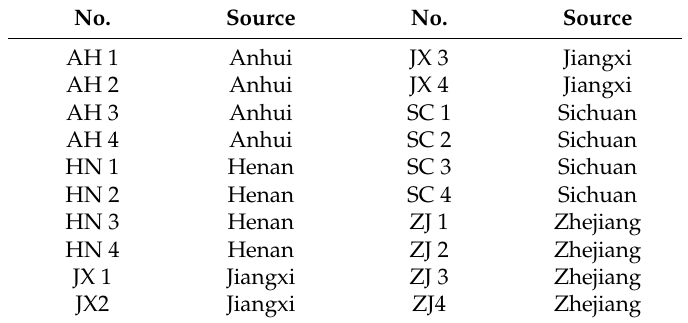
Table 3. Sources information of 20 batches of Chansu samples from di ff erent geographical origins. No. Source No. Source AH 1 Anhui JX 3 Jiangxi AH 2 Anhui JX 4 Jiangxi AH 3 Anhui SC 1 Sichuan AH 4 Anhui SC 2